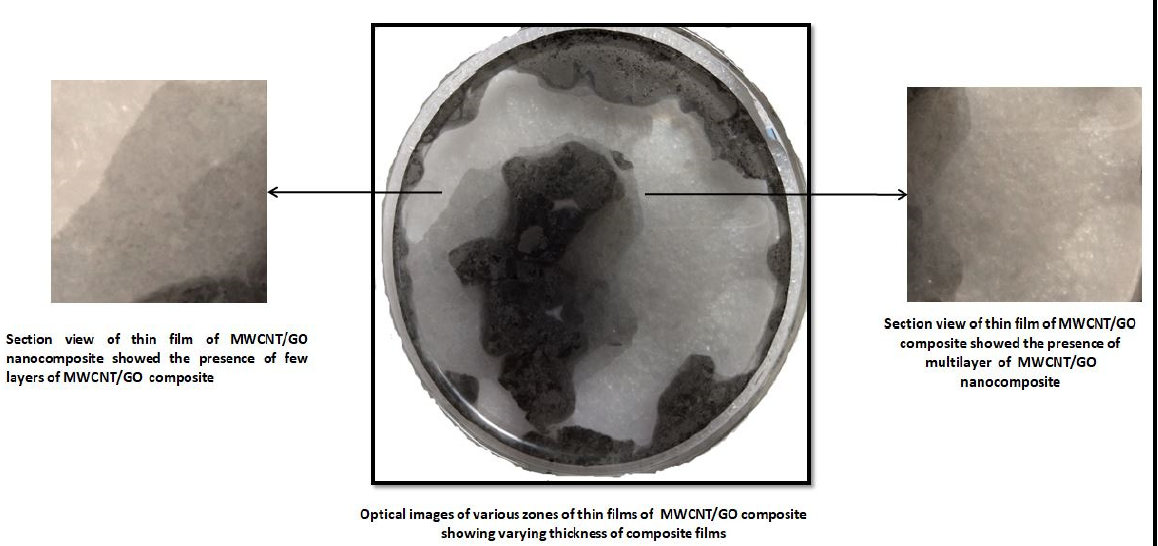
Figure 12. Optical image of the thin film of MWCNT/GO nanohybrid with a section view of the varying thickness of the film.